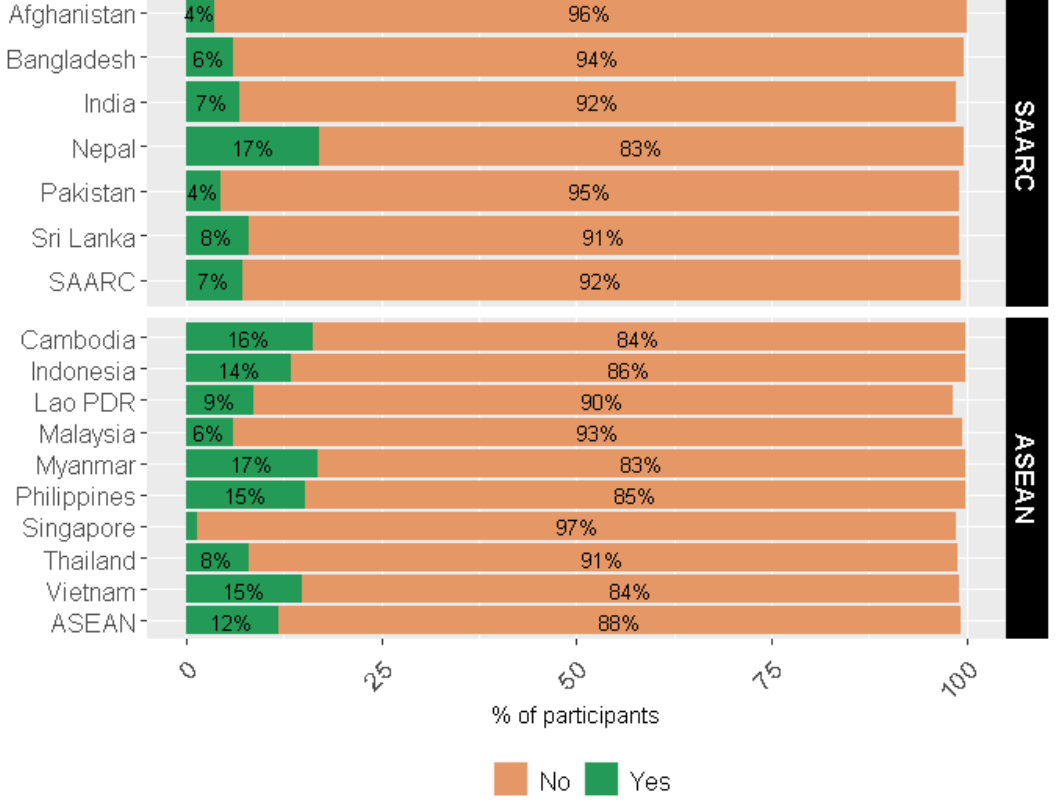
Figure 11. Percentage of participants who borrowed money for starting or operating a business.